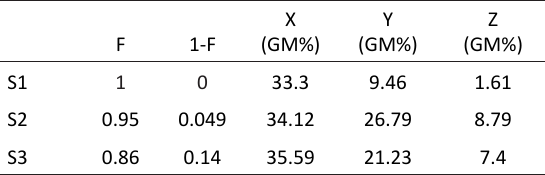
Table 3. Relative fraction (between 0 and 1) of endosperm (F) and embryo DNA (1-F) and GM percentages for the three different maize development stages calculated for different maize